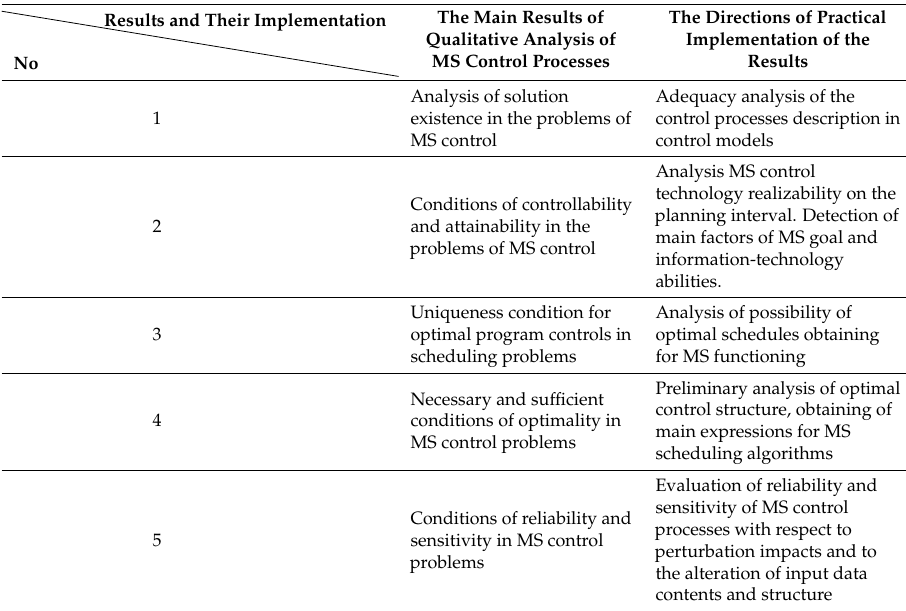
Table 1. Application of optimal control approaches to